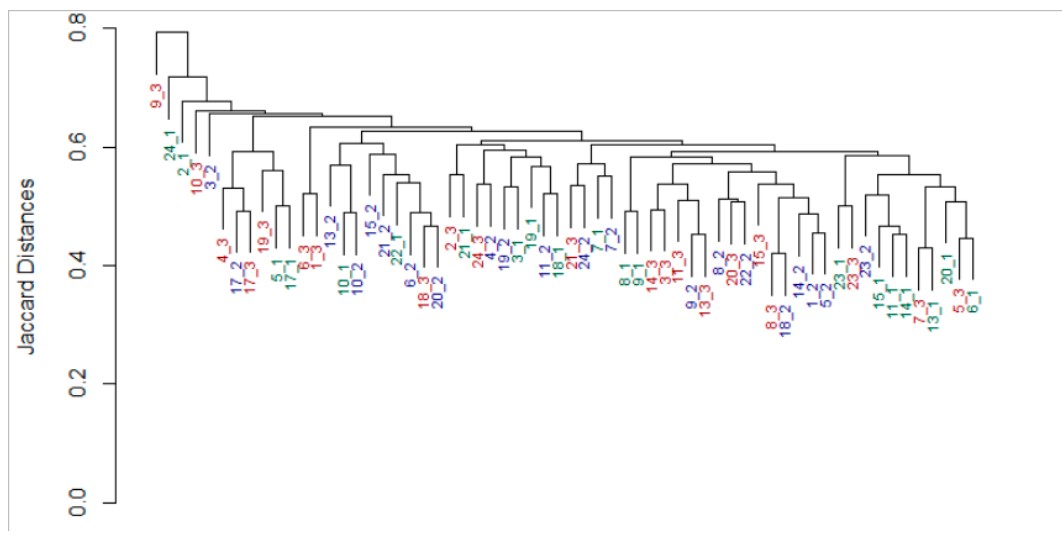
Figure 3. Subject identity in maternal microbiome. Dendrogram based on nearest neighbor joining of samples according to the Jaccard distance matrix of milk microbiome samples. Leaf labels show Subject ID and the time the sample was collected (green_week postpartum, red_one month postpartum, blue_three months postpartum). Analysis of similarities (ANOSIM): p = 0.002 R = 20%. *No data were available for participants number 12 and 16 .